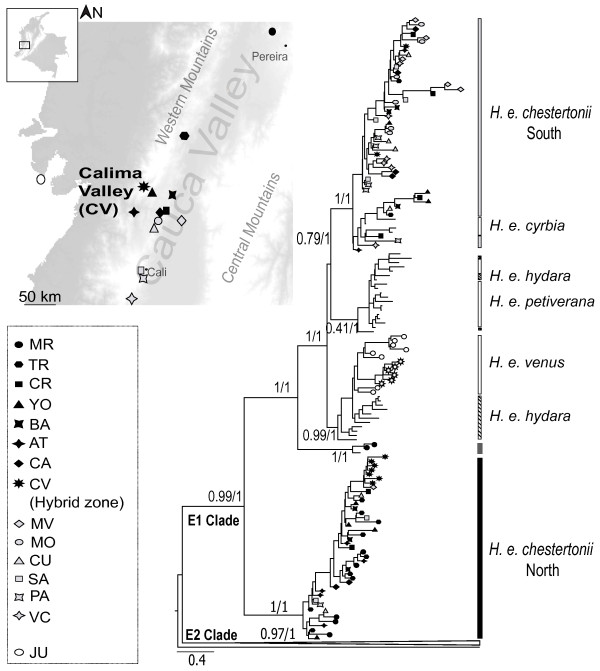
Sampling sites of Heliconius erato chestertonii and H. e. venus and bayesian tree for the Clade E1 of Heliconius erato. Symbols correspond to population of origin for the individuals of H. e. chestertonii, south (gray) or north (black) and H. e. venus (white). The tree is based on mitochondrial genes of Cytochrome oxidase subunits I and II, leucine-tRNA and has the same topology as the Parsimony analysis. Posterior probability and bootstrap support are indicated on branches of the principal clusters. Individuals of the different subspecies are identified by bars (right).